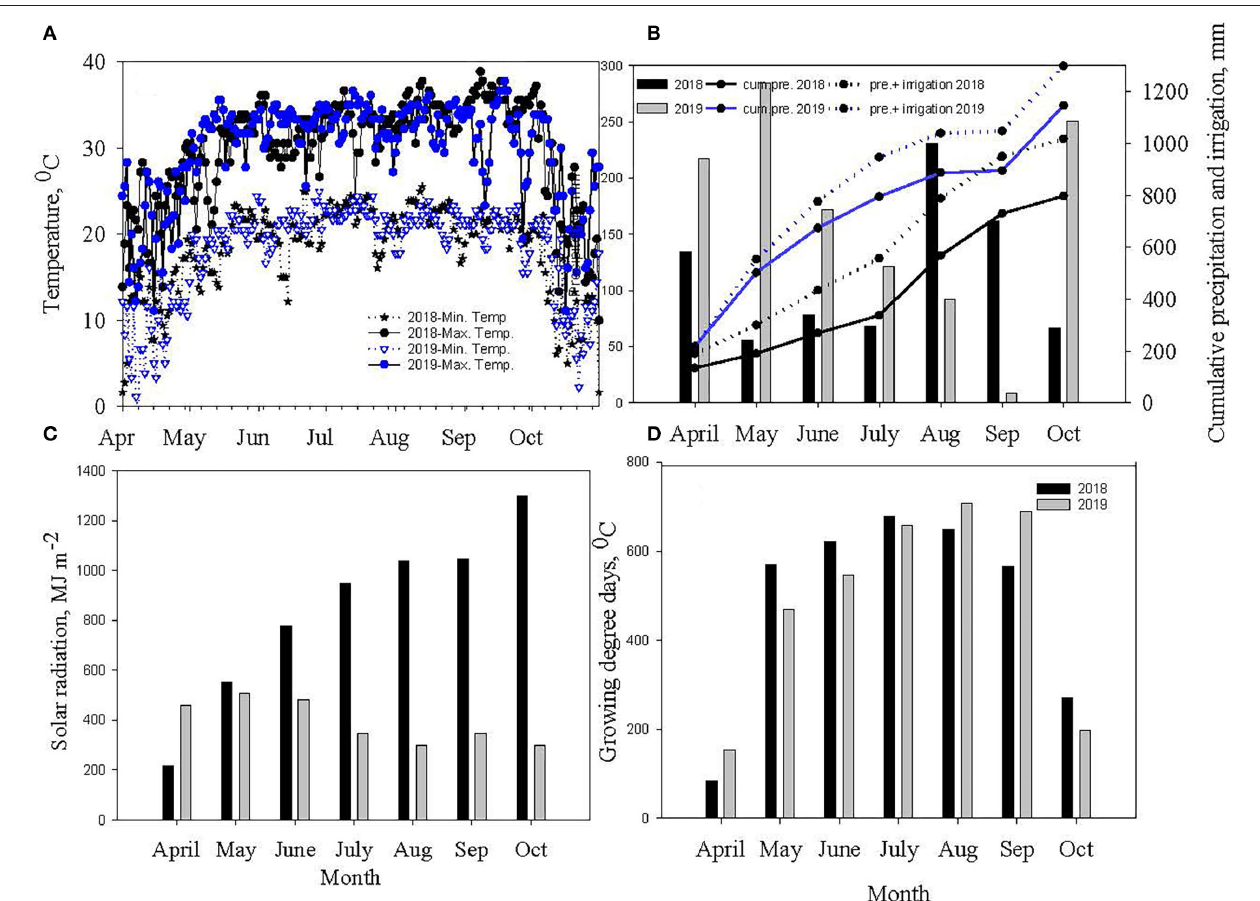
FIGURE 1 | Measured (A) daily air temperature and (B) monthly precipitation, and cumulative precipitation and irrigation (C) monthly solar radiation, and (D) monthly growing degree days (GDD) for 2018 and 2019 soybean and cotton growing seasons at Stoneville, MS.